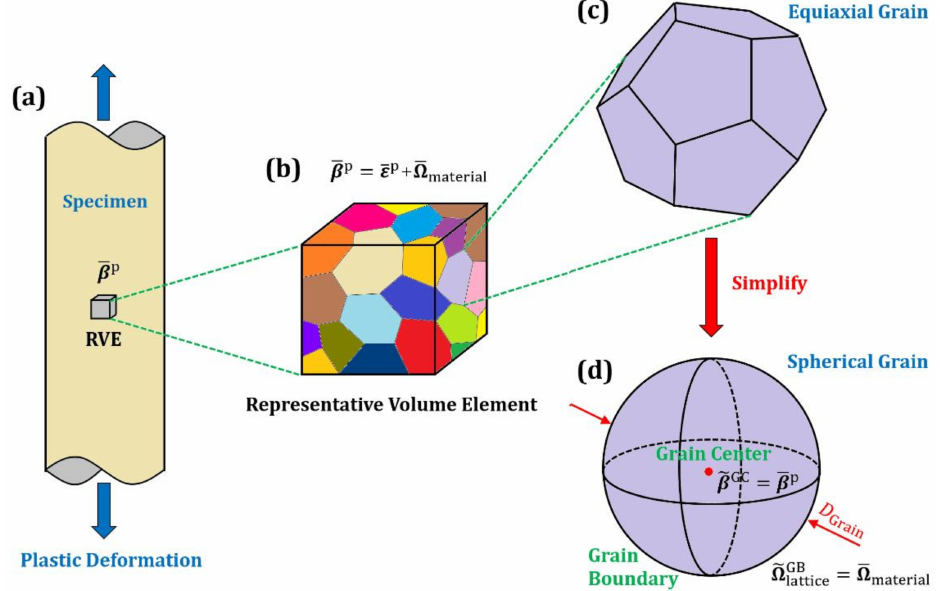
Figure 8. Several necessary simplifications for establishing the 3D polycrystalline plasticity model. ( a ) the macroscale plastic deformation applied in the specimen, ( b ) the mesoscale plastic strain and material rotation of a RVE containing multiple grains, as well as the microscale distortion in ( c ) an equiaxial grain and ( d ) a simplified spherical